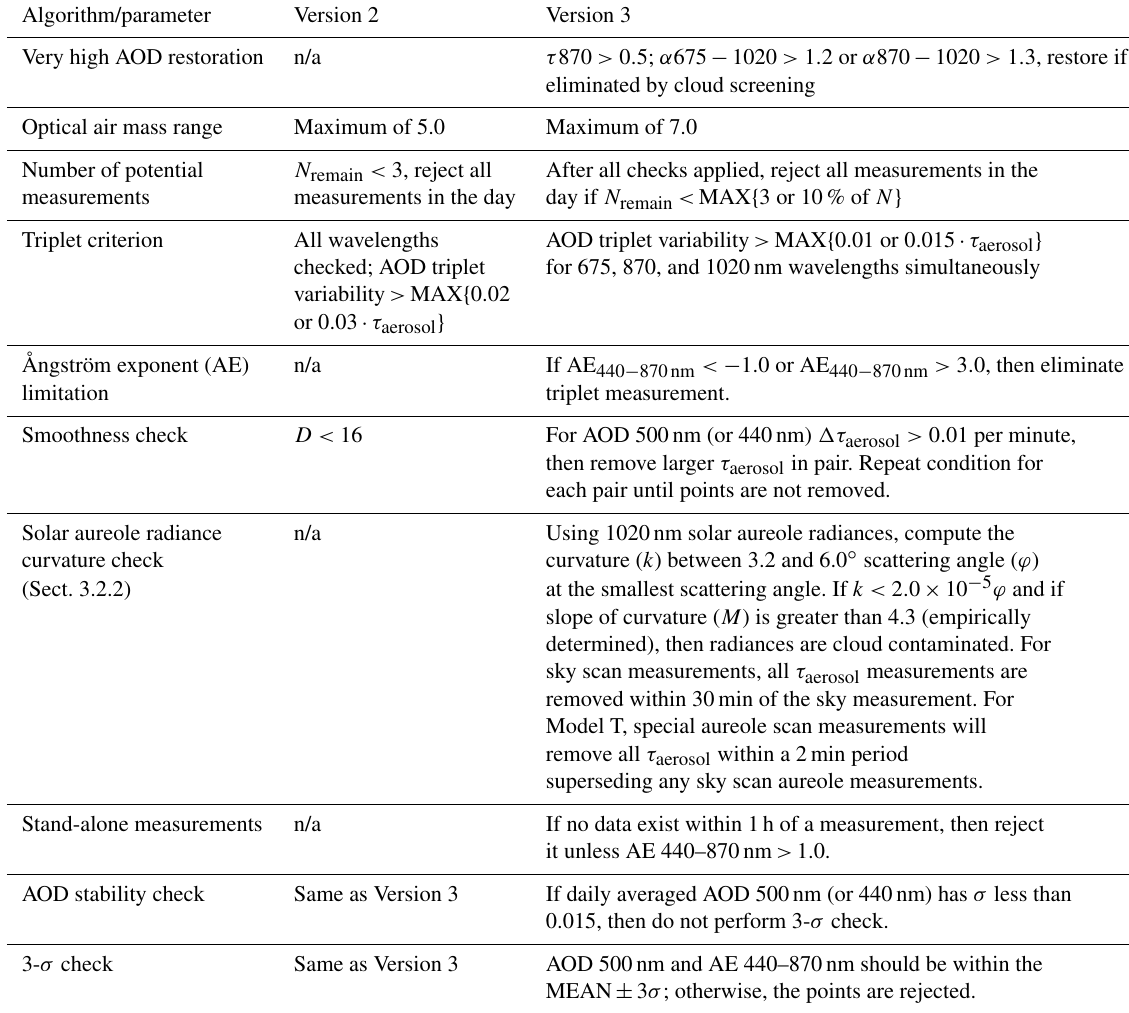
Table 2. Summary of cloud-screening-related quality control changes from Version 2 to Version 3.